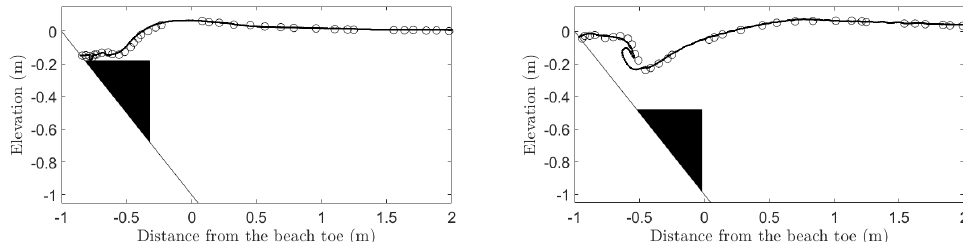
Figure 4. Reproduction of submarine landslide generated waves: snapshots of the free surface profile at two different time instants (Left: t = 0.5 s; Right: t = 1.0 s). Dot: model predictions. Circle: measurements reported by Heinrich [51].